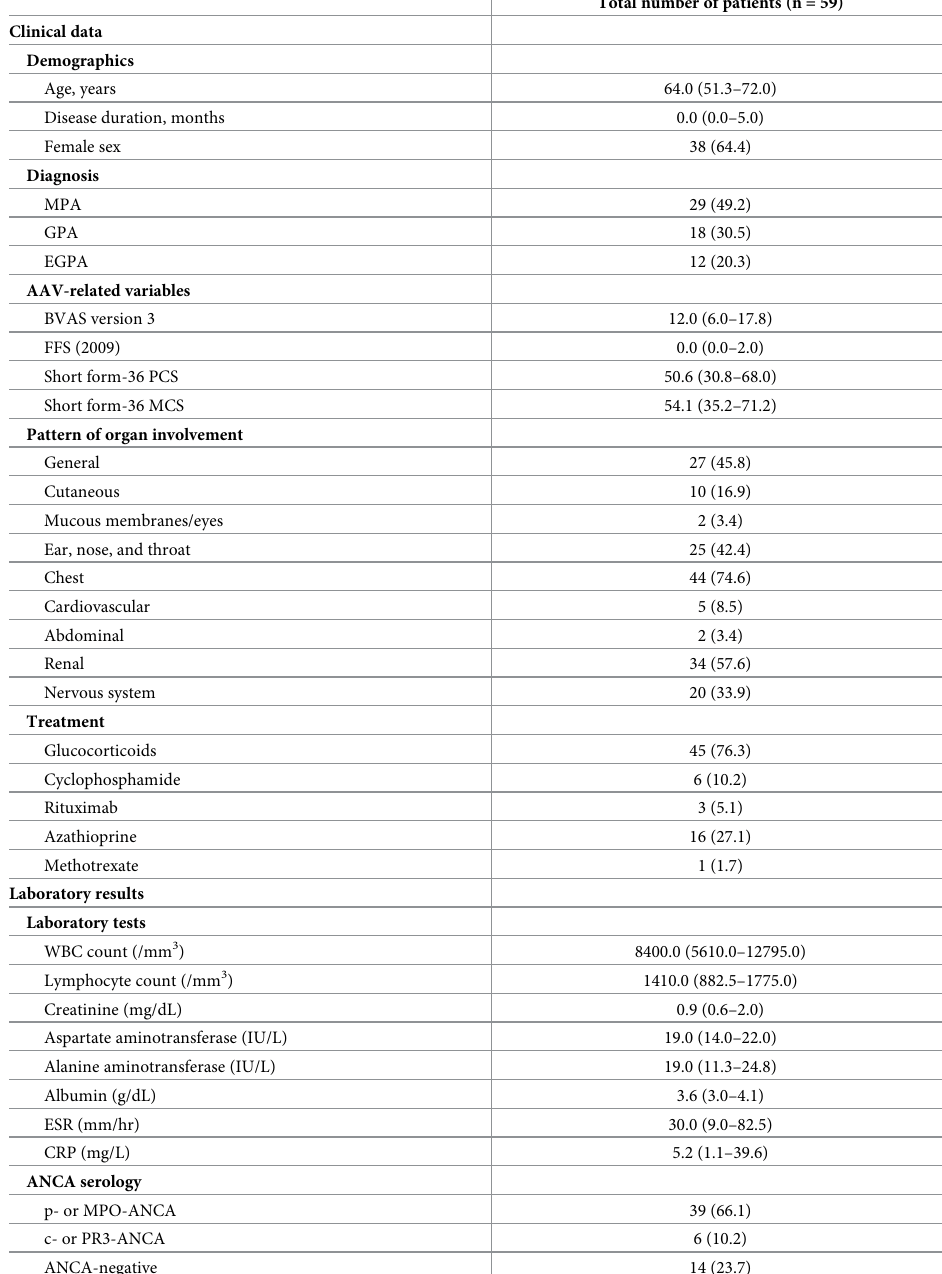
Table 1. Baseline clinical data and laboratory characteristics of